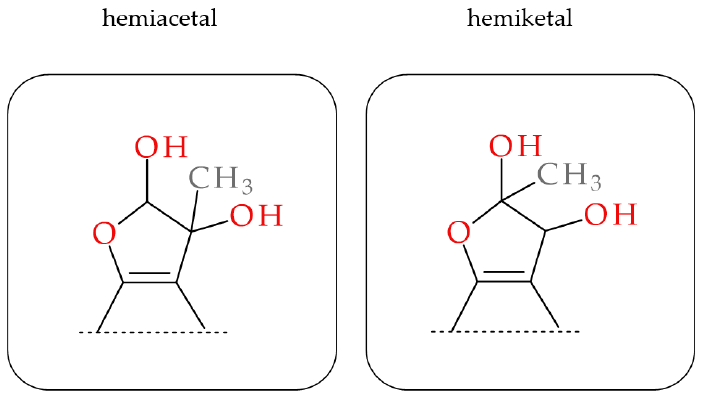
Figure 5. Scheme of the hemiacetal and hemiketal adducts of MGO with flavones and flavanones (2,3-dihydrofuran ring).